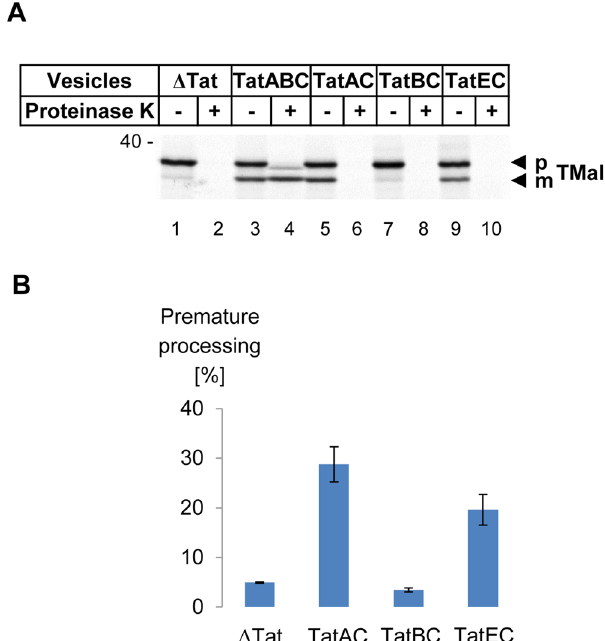
Figure 2. TatE partly prevents premature cleavage of the TorA signal peptide. ( A ) The Tat substrate TorA- MalE335 (TMal) was synthesized and radioactively labeled in vitro and incubated with inverted inner membrane vesicles obtained from E. coli strain BL21(DE3) Δ tat expressing the plasmid-encoded Tat components indicated. The samples were resolved by 10% SDS-PAGE and analyzed by phosphorimaging. In the presence of TatABC-containing vesicles, cleavage of the precursor (pTMal) to the mature protein (mTMal) is accompanied by the acquirement of proteinase K resistance (compare lanes 2 and 4) indicating transport into the lumen of the vesicles. Vesicles lacking TatB cleave pTMal (lane 5) but do not allow transport to occur (lane 6, no protease resistance). TatB (lane 7) and to a lesser extent TatE (lane 9) prevent this premature cleavage. ( B ) Quantification of premature processing of pTMal to mTMal by the indicated membrane vesicles was obtained from nine independent experiments using vesicles from two different preparations each, except for Δ Tat vesicles (three experiments, one